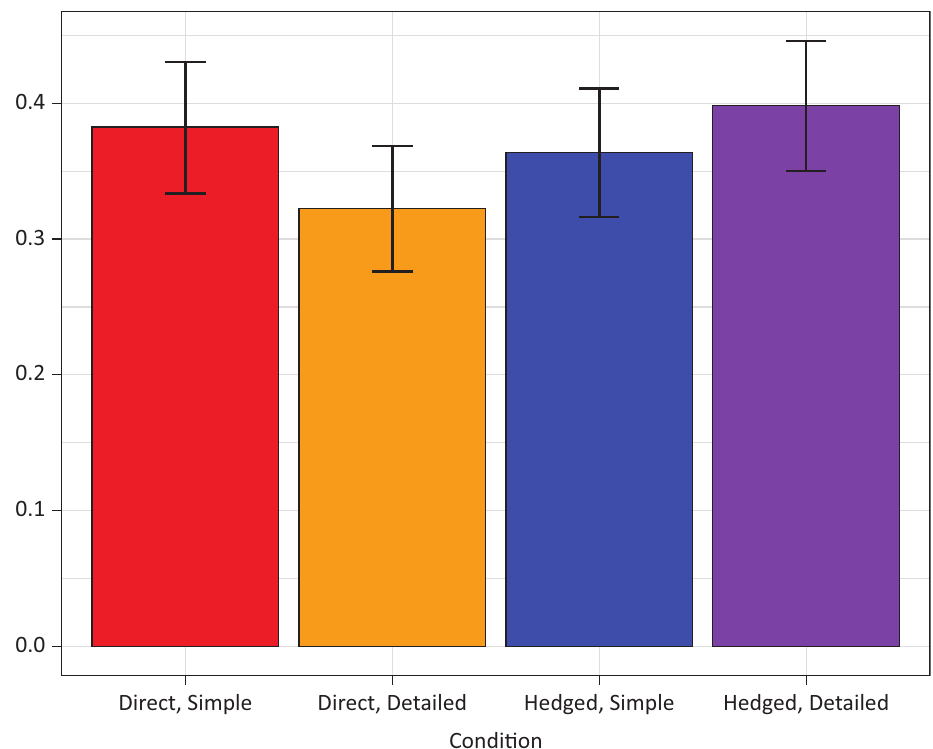
Figure 3. Likelihood of reply to the corrective message by condition. Notes: N = 1,589. Error bars reflect 95% confidence